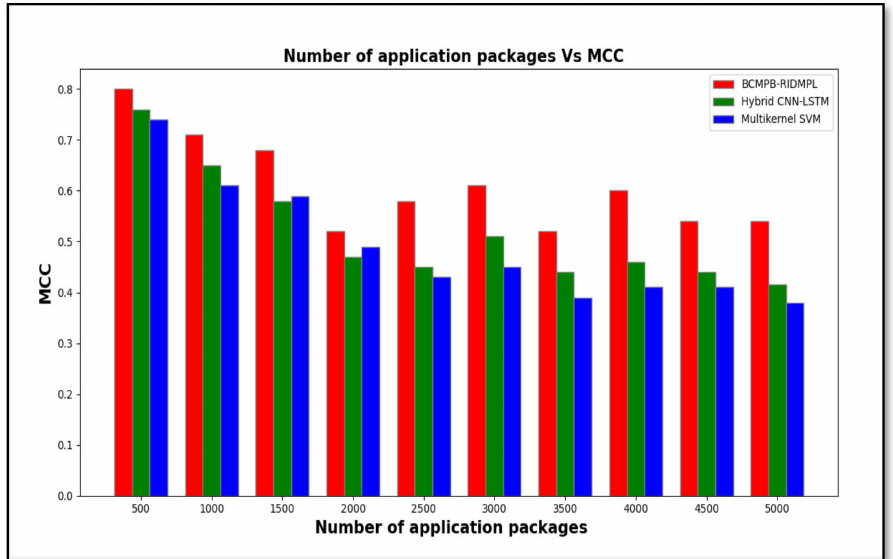
Figure 8. Graph of Matthews correlation coefficient of BCMPB-RIDMPL, CNN-LSTM and multi- kernel SVM method under